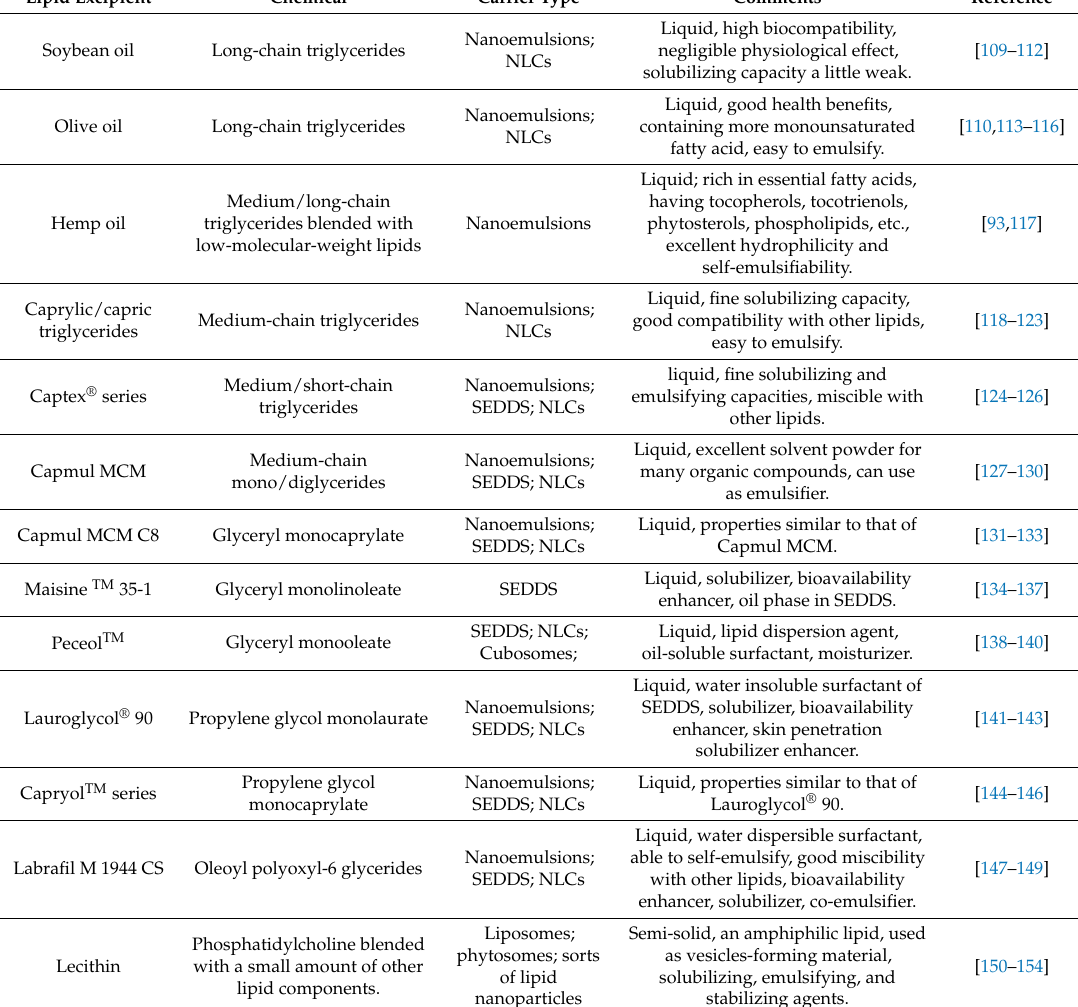
Table 2. Commonly used lipid excipients in lipid-based